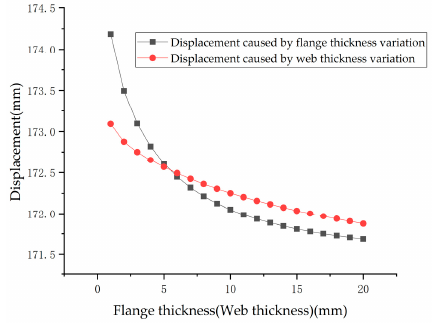
Figure 9. Sensitivity curve of C S height and width.